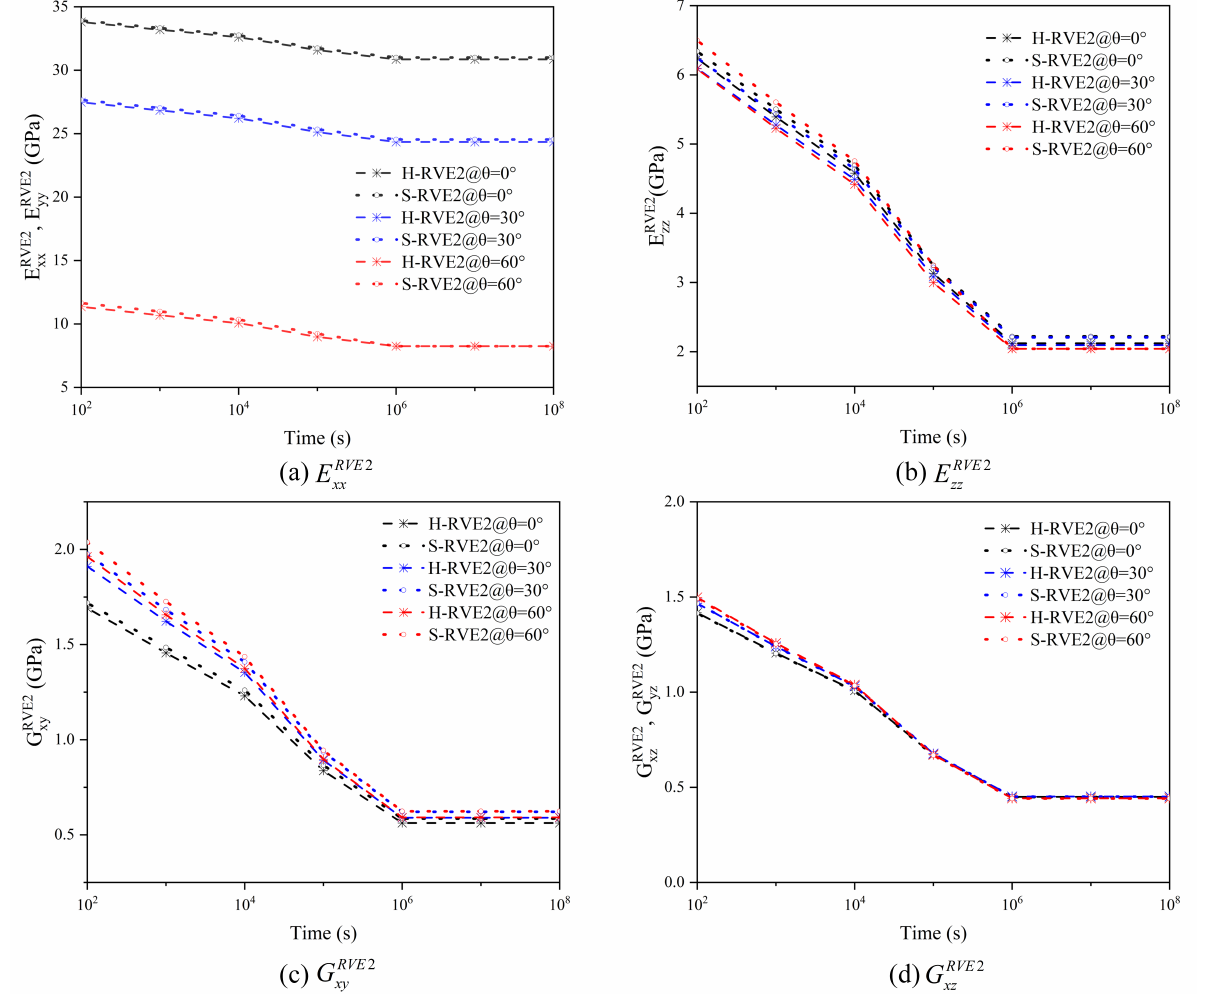
Figure 11.Figure 11. Effect of the twist angle on the effective relaxation moduli of 2D woven composite.